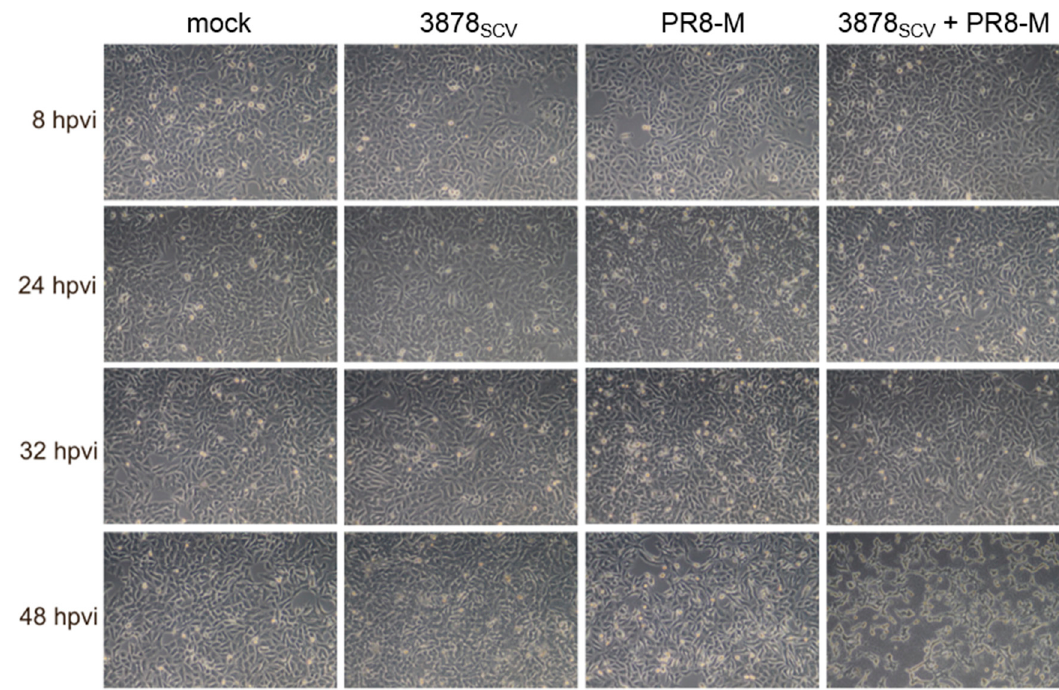
Figure 1. S. aureus 3878 SCV colonization and subsequent influenza virus infection provokes a cytopathic effect. A549 human lung epithelial cells were infected with S. aureus 3878 SCV (multiplicity of infection (MOI) = 0.01) for 24 h at 37 °C and 5% CO 2 . Afterwards, cells were infected with influenza viruses (IV) Puerto Rico/8 (PR8)-M (MOI = 0.1) until the indicated points in time (hours post-viral infection, hpvi). Cells were visualized by light microscopy with a 10× magnification. Shown are representative images of three independent experiments ( n = 3).